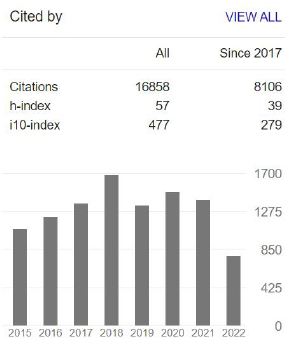
Figure 2. Statistics from Qi’s Google Scholar profile dated on 2 August 2022.